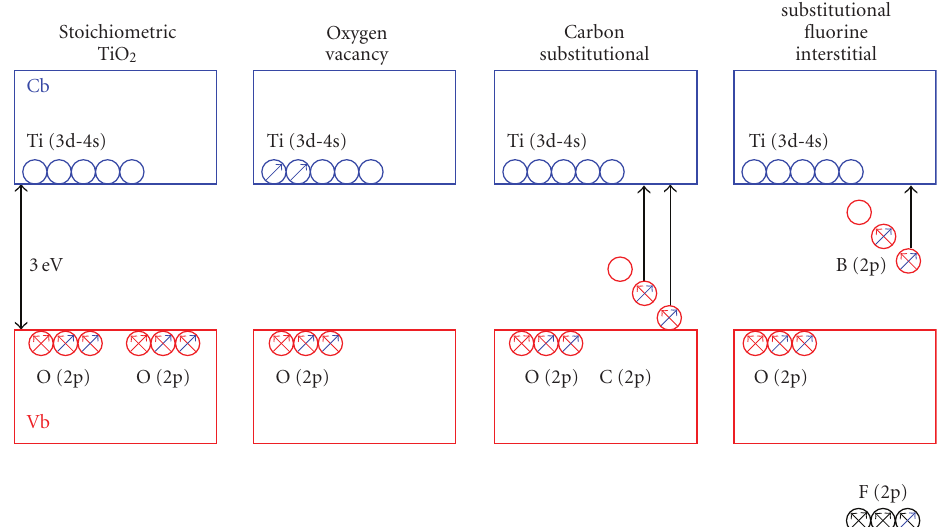
Figure 3: Schematic representation of the electronic structure. (a) Far left: TiO 2 , (b) left center: with oxygen vacancy, (c) right center: with carbon doping, (d) far right: with B and F codoping. The valance band is principally oxygen 2 p in character. The conduction band is principally Ti 3 d & 4 s in character. In the atomic limit, each TiO 2 unit contributes two filled oxygen 2 p orbitals, four half-filled oxygen 2 p orbitals, and four titanium valance electrons. In the pure material, (far left) the four titanium valance electrons fill the vacant oxygen 2 p orbitals. When an oxygen atom is removed, (center left) three oxygen 2 p orbitals are removed, but only 4 electrons. The remaining two electrons are forced to reside in Ti 3 d orbitals. Upon substitution of C for O, (center right) the carbon 2 p bands “float up” into the band gap due to weaker nuclear-electron interaction. Onsets in the photoabsorption spectrum are seen corresponding to transitions from both occupied carbon 2 p bands to the conduction band. B-F codoping (far right) fills the half-full F-2 p orbital with a large energy